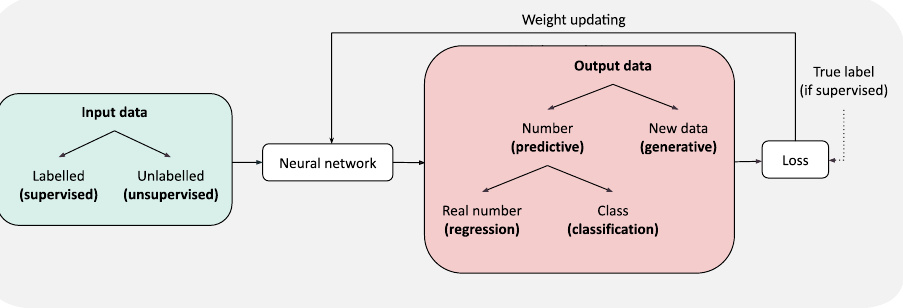
Figure 2. General pipeline of neural network training. Input data is in green, output in red. The types of model are written in